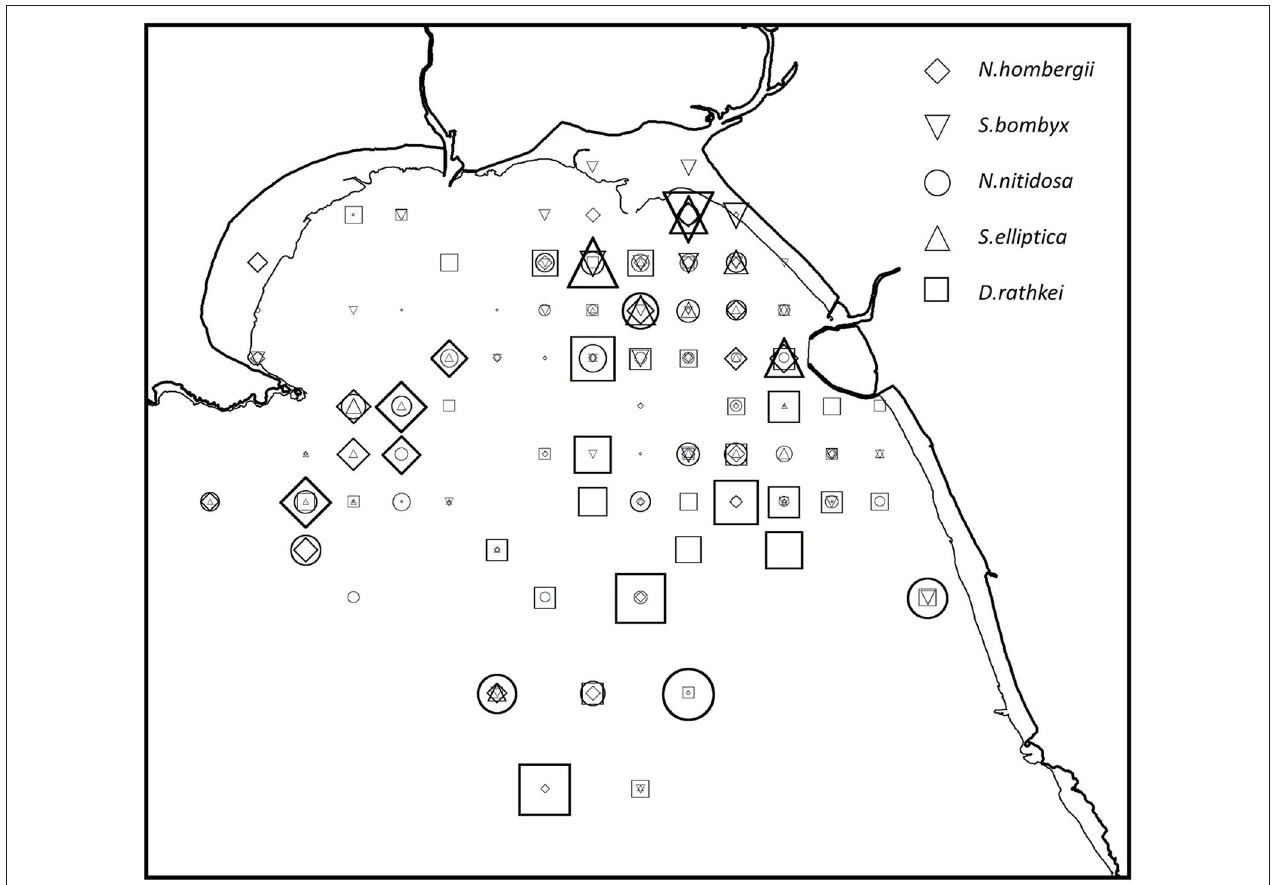
FIGURE 3 | Distribution of species recorded in 1984 and 2014 which were identified by inverse classification as an association with similar spatial trends in both studies. The size of symbols represents the relative abundance of species in the 2014